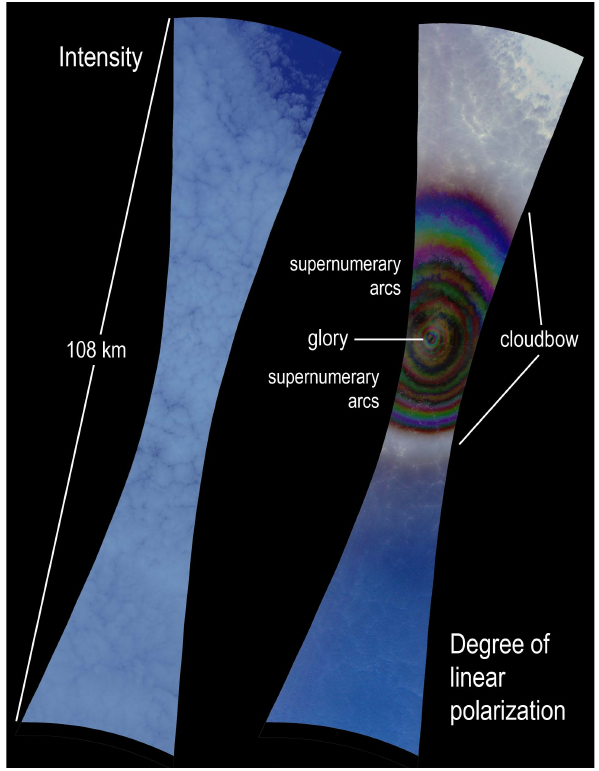
Fig. 18. AirMSPI stratocumulus cloud imagery at 470, 660, and 865nm (left panel: intensity; right panel: DOLP) acquired in sweep mode on 31 August 2011 off the coast of California. In the DOLP image, the colored rings between the glory (near 180 ◦ scattering angle) and primary cloudbow (near 143 ◦ scattering angle) are su- pernumerary arcs – interference fringes resulting from the narrow spherical droplet size distribution. Multiple scattering washes out these features in the intensity image, but the glory is faintly visible.